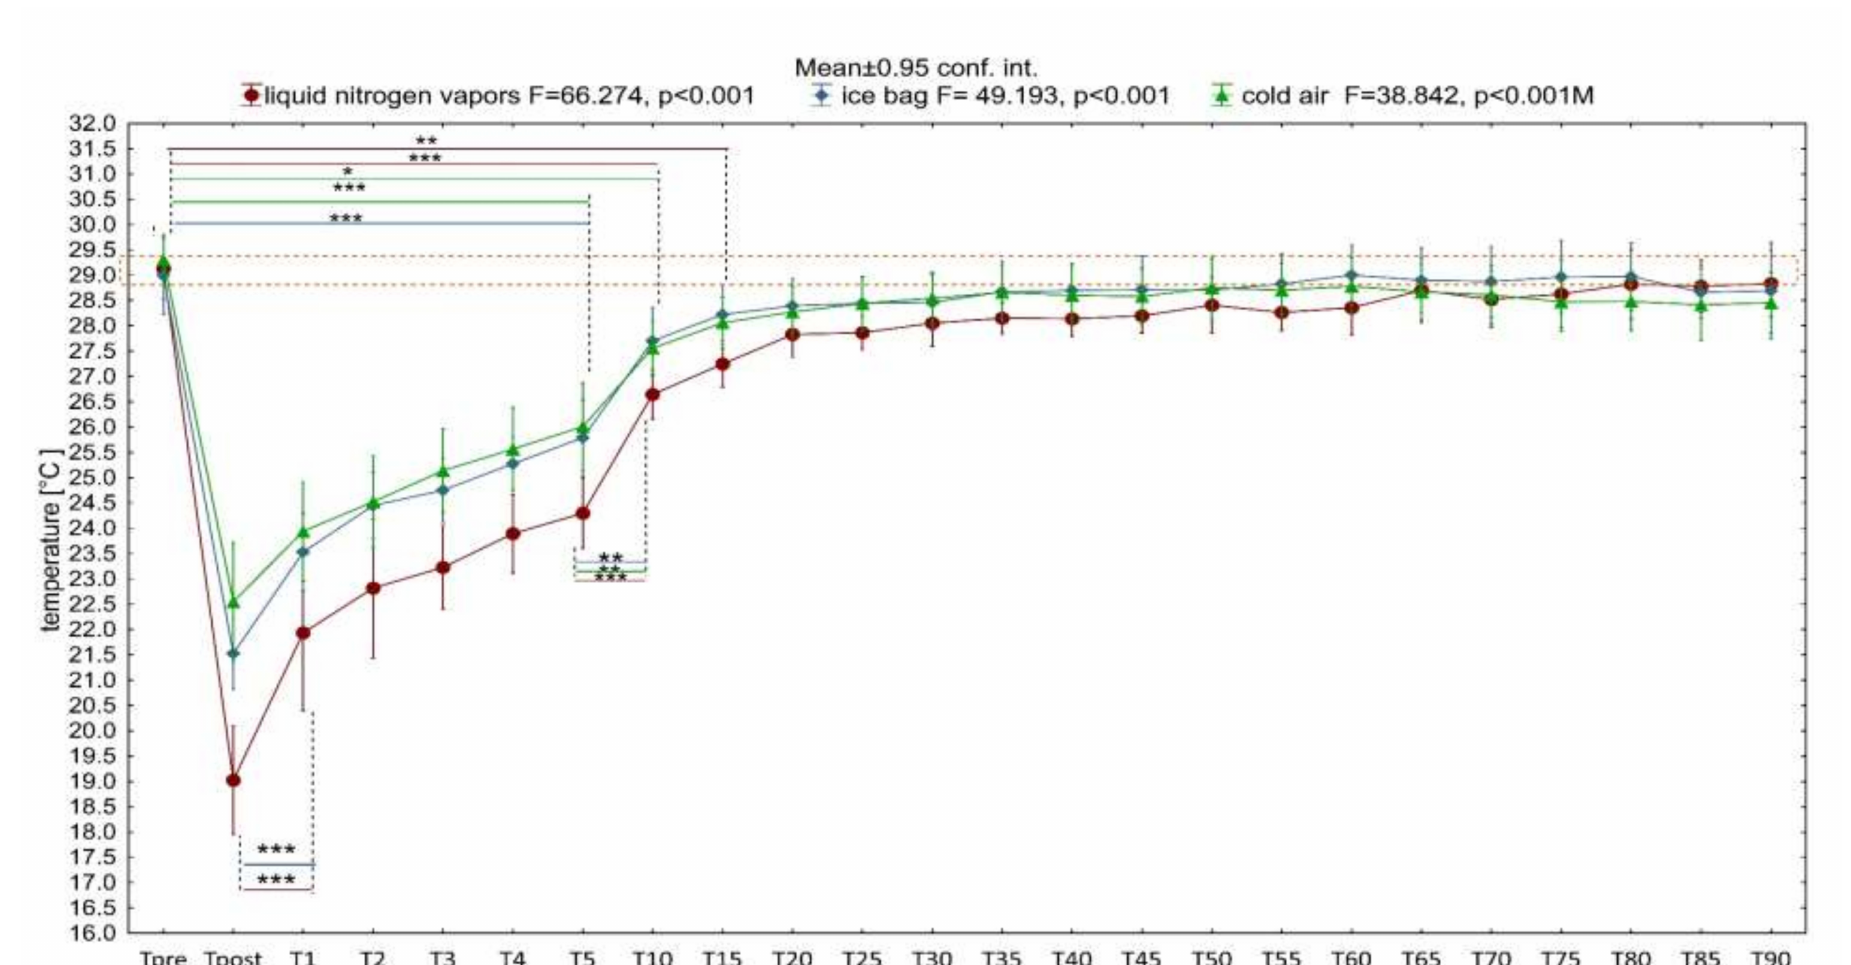
Figure 3. Change in the mean surface temperature of the knee joint after a 3-min application of three cooling agents. Legend: Data are expressed as mean with standard deviation. The dashed orange line represents the average ROI temperature before exposure. Two-way repeated measures ANOVA, F—ANOVA value, p —test probability level, test probability level determination for Tukey’s HSD post hoc tests: * p <0.05, ** p <0.01, *** p